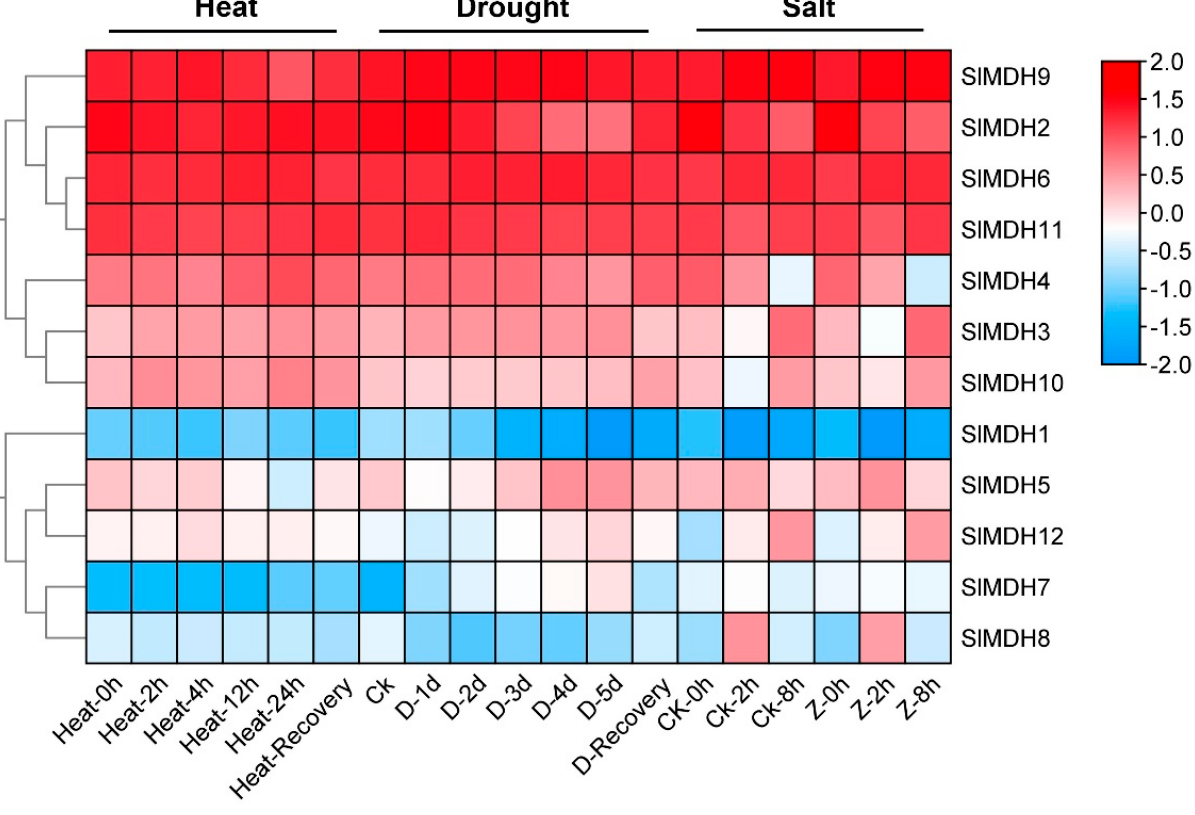
Figure 6. Gene expression analysis of tomato MDH genes under heat, drought, and salt stress using RNA-sequencing data. “D” and “Z” indicate drought and salt, respectively. The expression values were calculated by Log 2 (FPKM) and presented according to the color code.